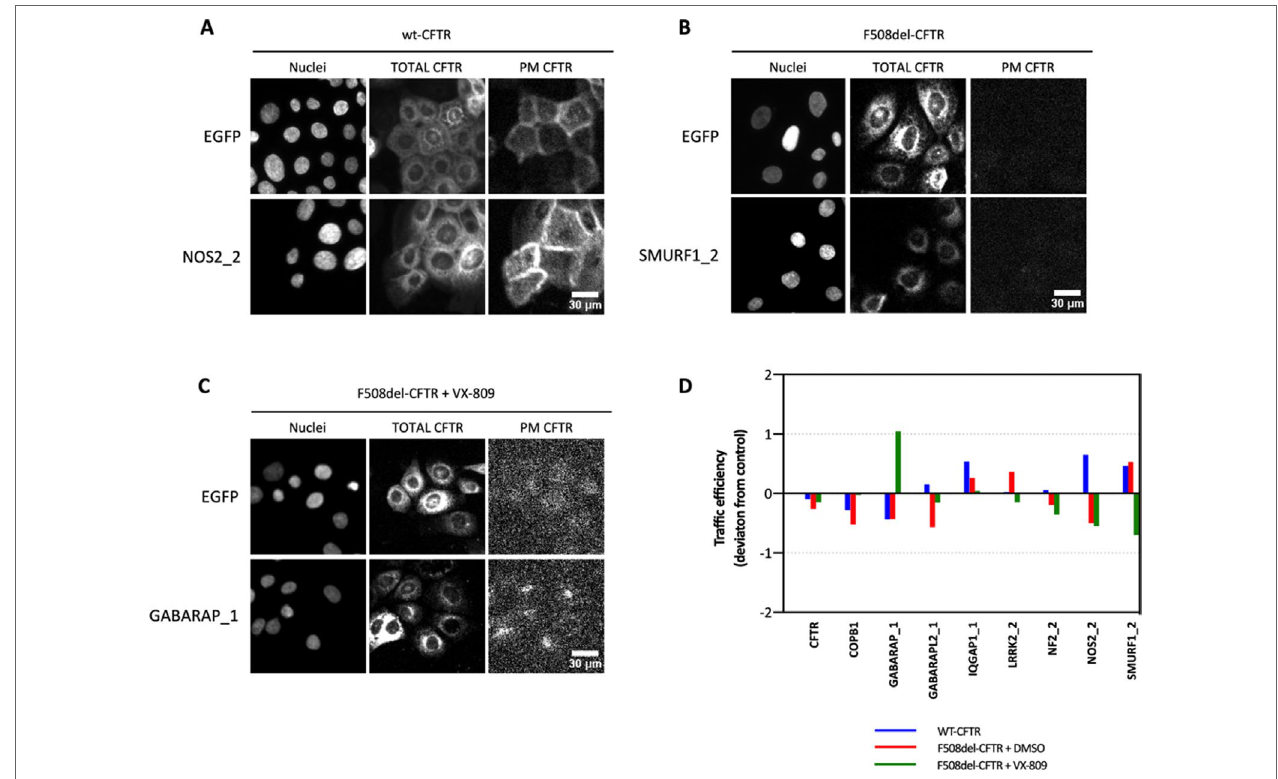
FIGURE 2 | CFTR trafficking upon knock-down of the possible hits. CFBE cell lines expressing mCherry-Flag-wt-, mCherry-Flag-F508del-, and mCherry-Flag- F508del-CFTR treated with VX-809 (3 μM for 48 h) under the control of a doxycycline-inducible promoter were transfected with siRNAs targeting CUL3, GABARAP, GABARAPL1, GABARAPL2, ILK, IQGAP1, LRRK2, NF2, NOS2, SMURF1, and UBASH3B. NT (non-treated cells) and COPB1 and EGFP (no-target siRNA) siRNA were used as controls. (A–C) Representative images for the three cell lines and one target for each cell line. PM CFTR image contrast was optimized after quantification to allow visualization of detected signal differences. (D) The CFTR traffic efficiency is obtained with the ratio PM/total CFTR with PM CFTR assessed by Flag staining (Cy5 fluorescence) and the amount of total CFTR with the mCherry signal. Data are shown as the deviation score as detailed in Formula 2, where positive values correspond to traffic efficiencies larger than the negative control (siRNA against EGFP) and negative values correspond to traffic efficiencies lower than the negative control, n = 3.